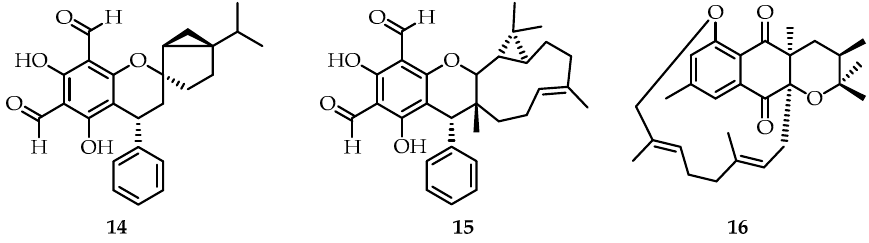
Figure 5. Structures of psiguajavadials A ( 14 ), B ( 15 ) and napyradiomycin D1 ( 16 ).